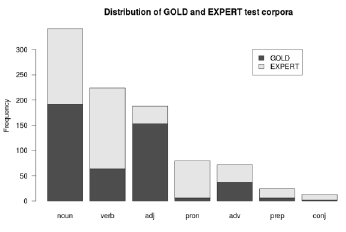
Figure 5. IceMorph uses two distinct test sets to evaluate classification performance. Corpus GOLD consists of 462 randomly selected corpus words. Corpus EXPERT, on the other hand, consists of 488 words tagged by expert users. This figure shows the relative frequency of POS in EXPERT and GOLD.